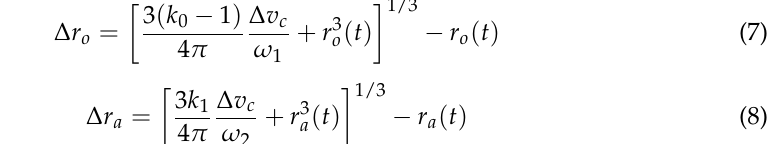
Figure 4. The hydration process: ( a ) 3 d, ( b ) 7 d, and ( c ) 28 d.